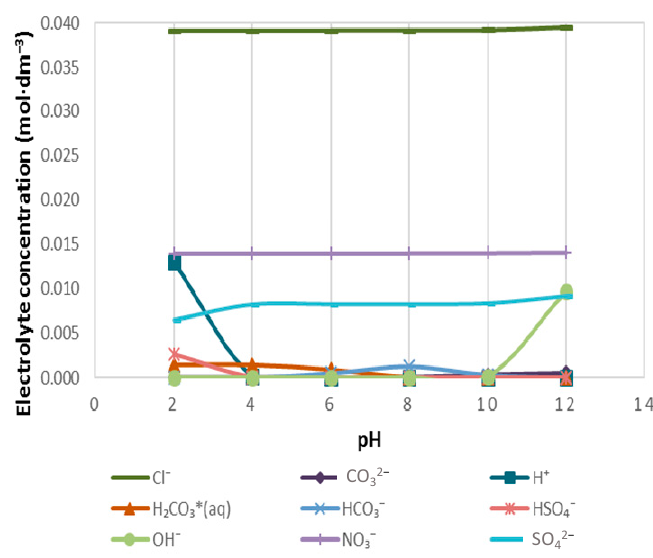
Figure 9. The speciation of cation-free anions in 5SPW.